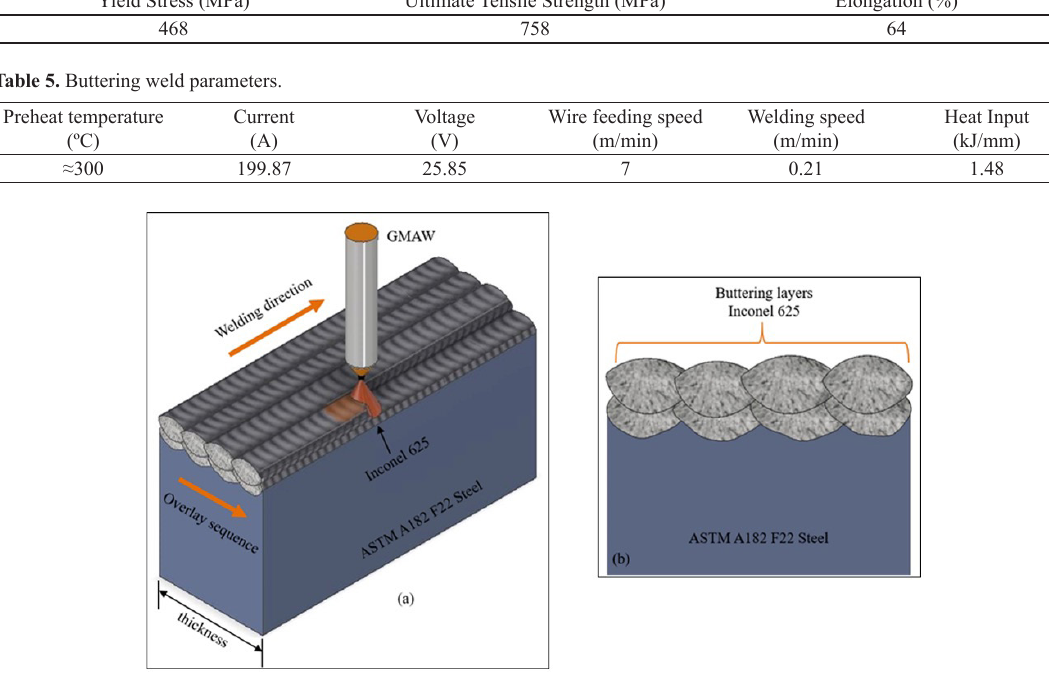
Figure 1. Buttering weld. Procedure (a) and its transversal section (b).